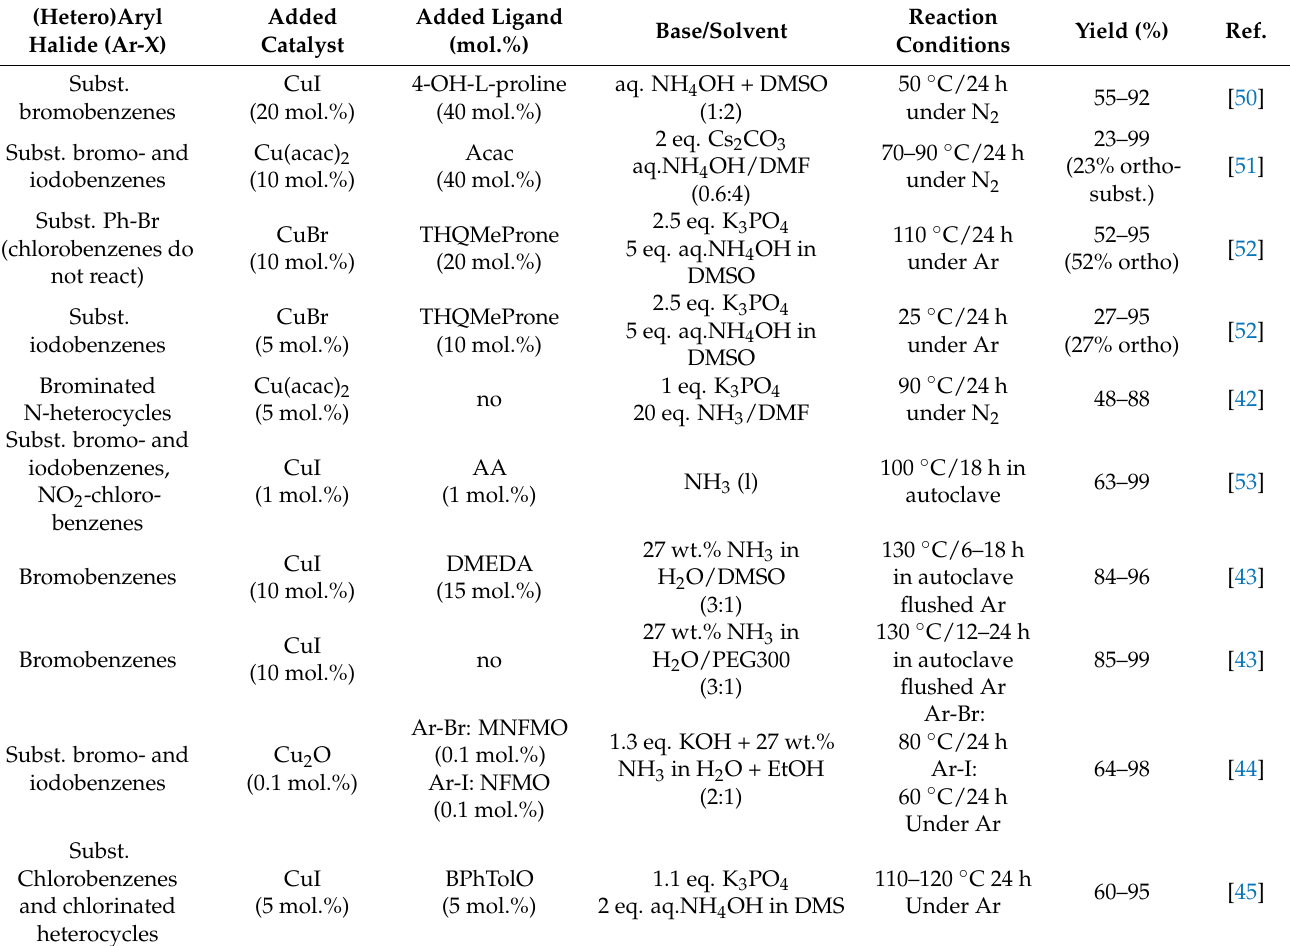
Table 2. Cu-catalyzed amination of (hetero)aryl halides using NH 3 or NH 4 OH.